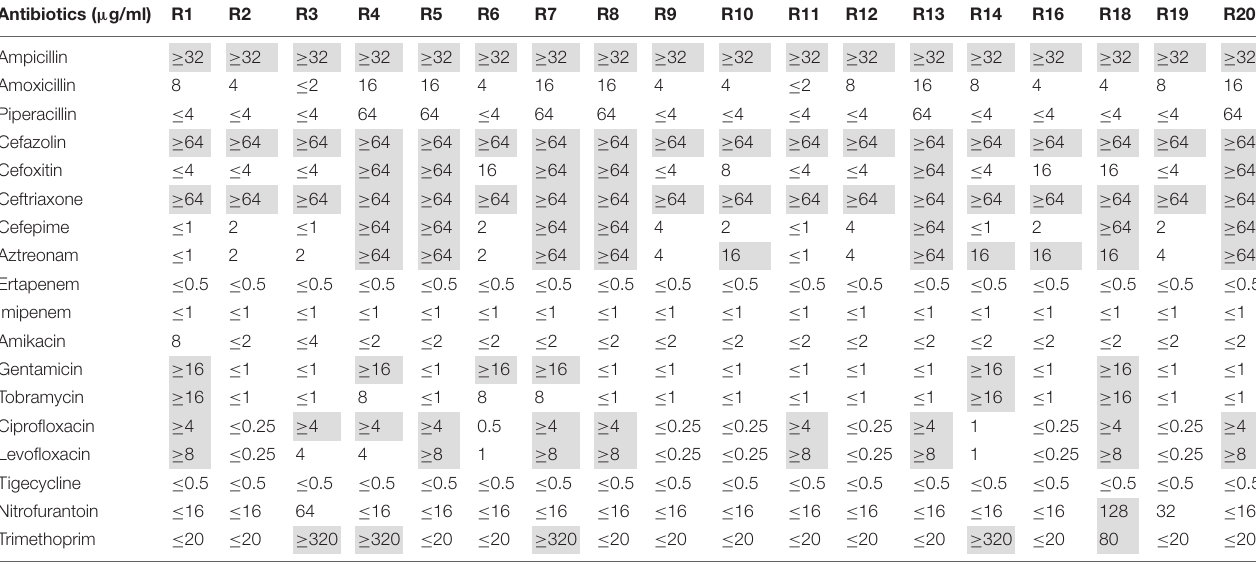
TABLE 1 | MIC values of all 18 E. coli